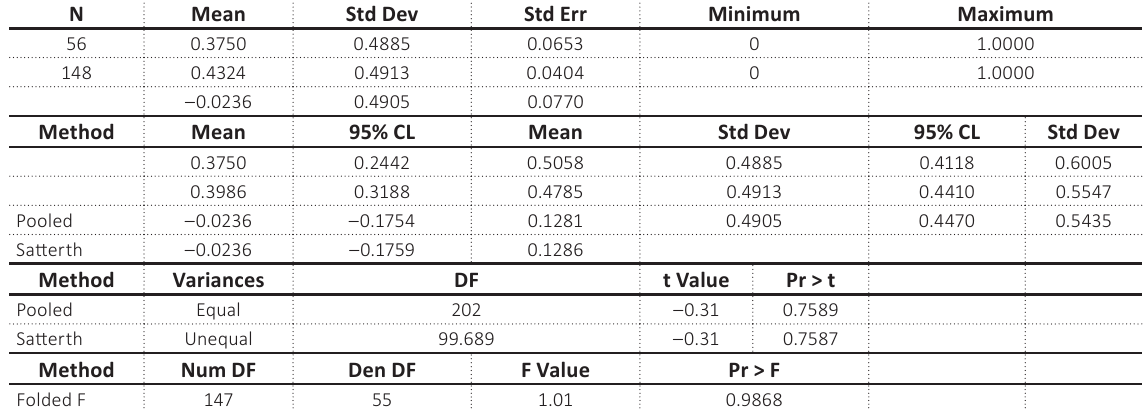
Source: Authors’ processing using SAS